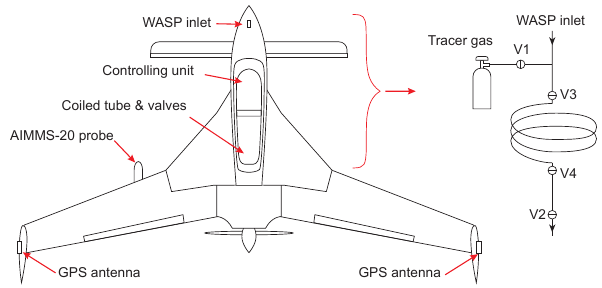
Fig. 1. Schematic drawing of the long-EZ aircraft and WASP. V1 and V2 are solenoid valves, V3 and V4 are ball